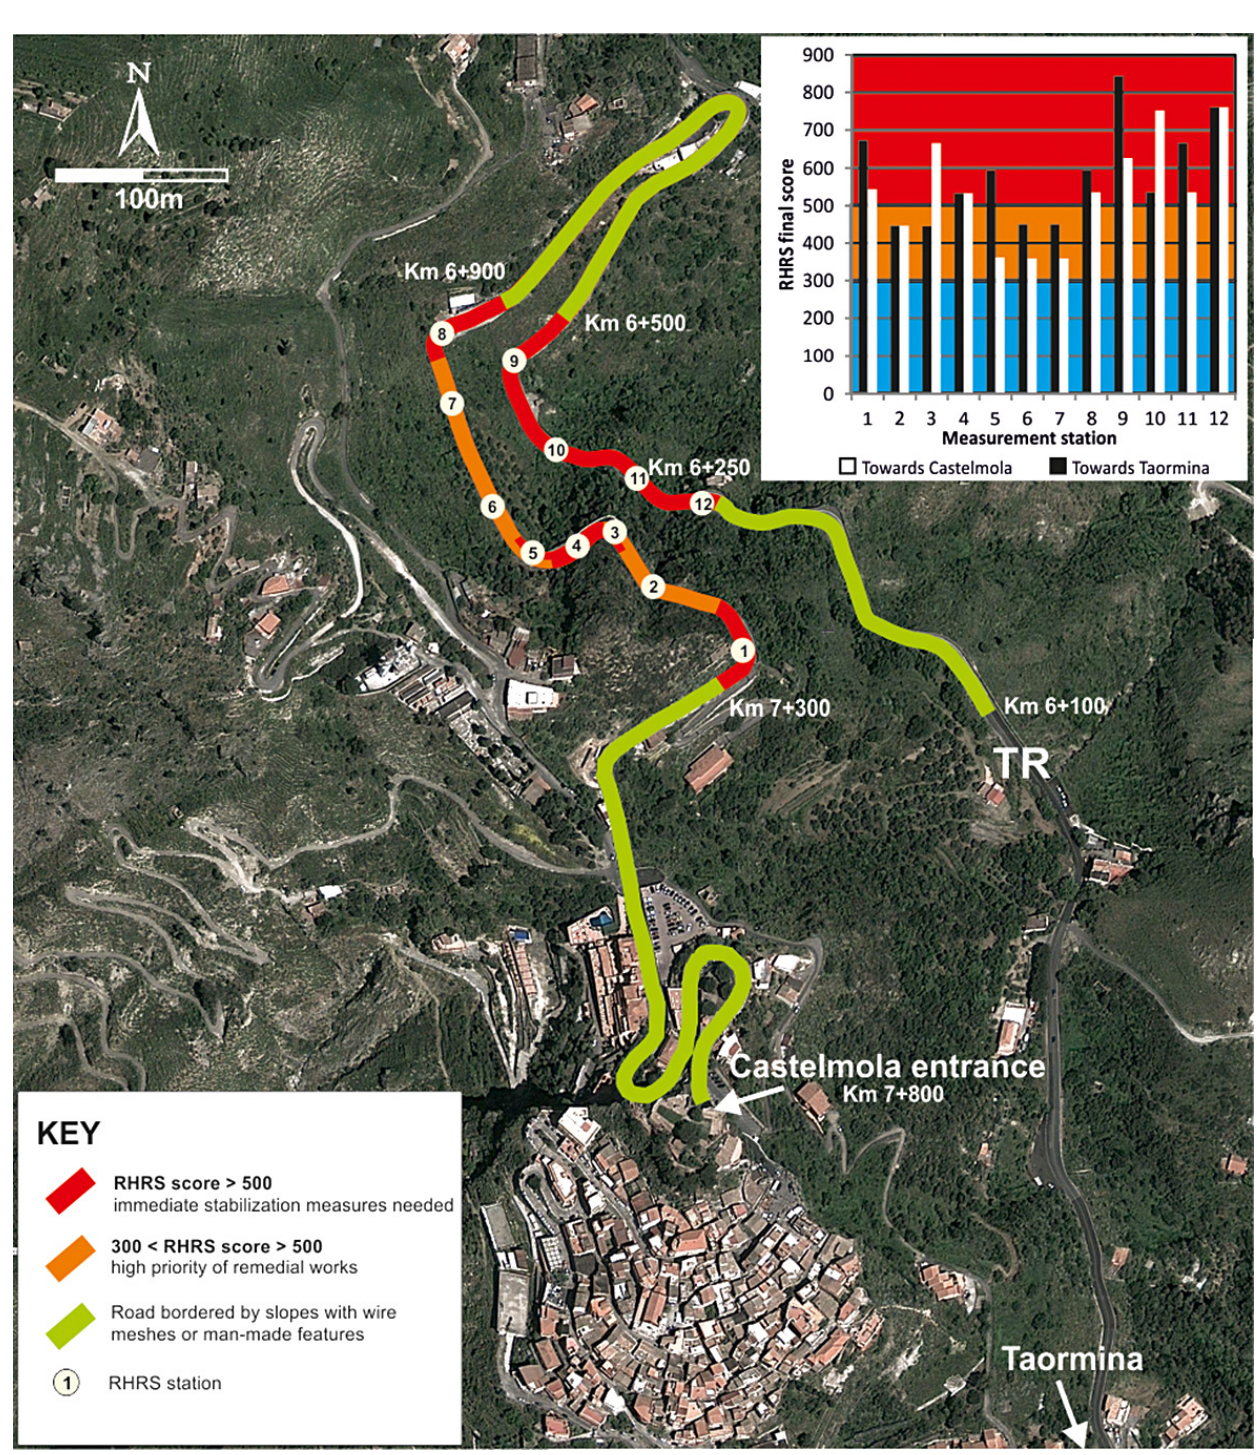
Figure 7. Taorminese Road hazard distribution. The histogram in the upper right corner shows the final RHRS scores for each measurement